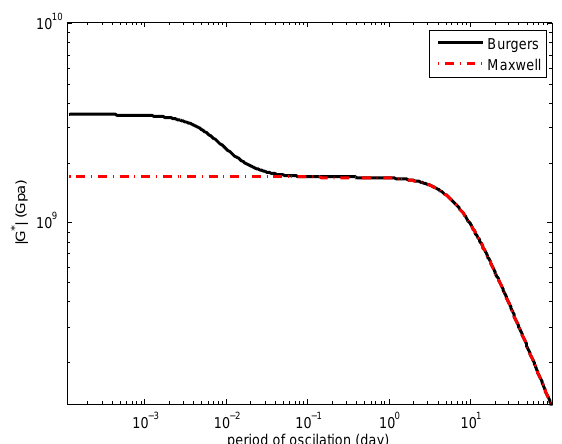
Fig. A1. The complex shear moduli of the Burgers and Maxwell models. The parameters of the Burgers model are based on values suggested by Reeh (2003). Using Eqs. A12 and A13 the parameters of the Maxwell model are set such that the complex shear moduli of the Maxwell model is equal to that of the Burgers model for loading periods larger than about few